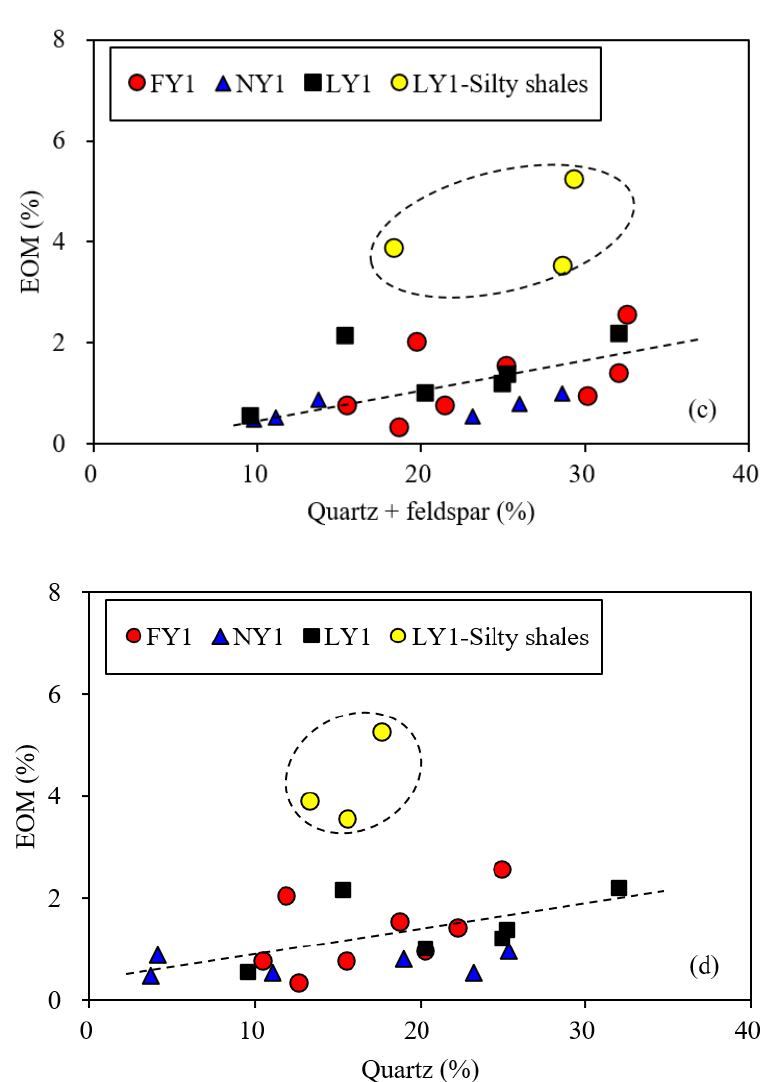
Figure 10. Plots showing relationship of EOM with clay minerals ( a ), carbonate minerals ( b ), quartz and feldspar ( c ), and quartz ( d ) for the studied samples. The three LY1 silty shale samples were expected for the linear regressions (see Table 1).